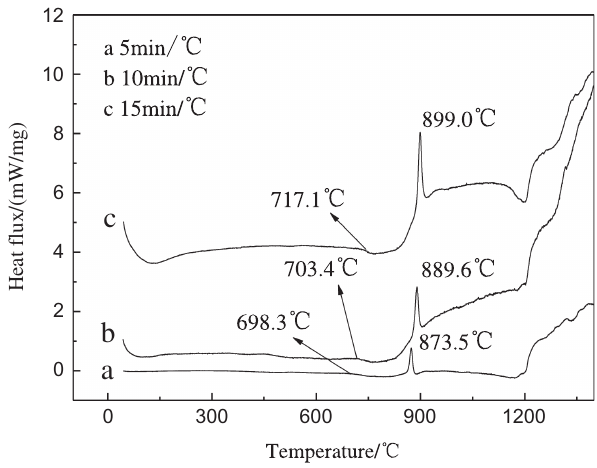
Figure 4: DSC curve of fibers at the acidity coefficient of 1.3.